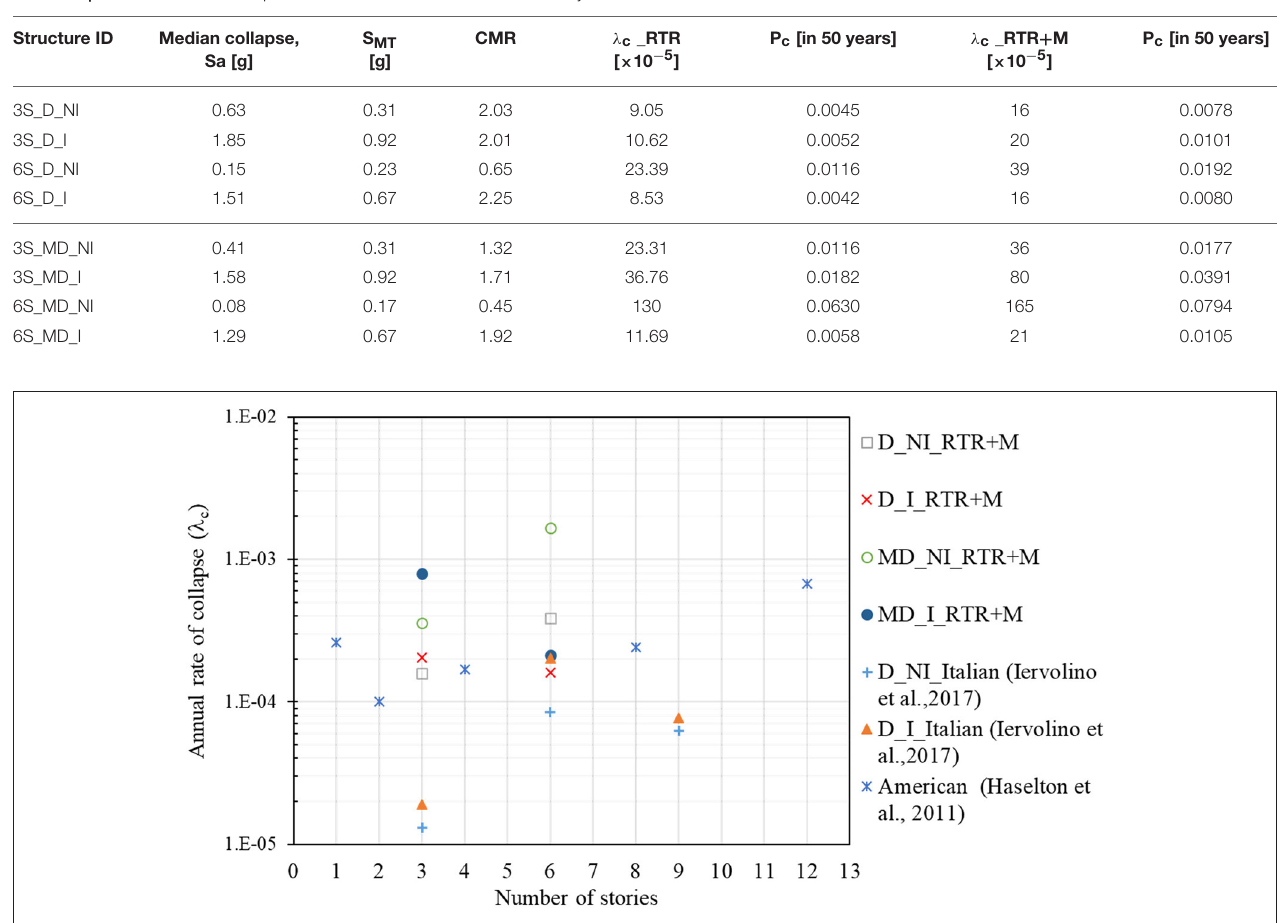
FIGURE 10 | Mean annual frequency of collapse for ductile and moderately ductile RC MRF buildings with and without URM infill walls comparison with other building design codes.